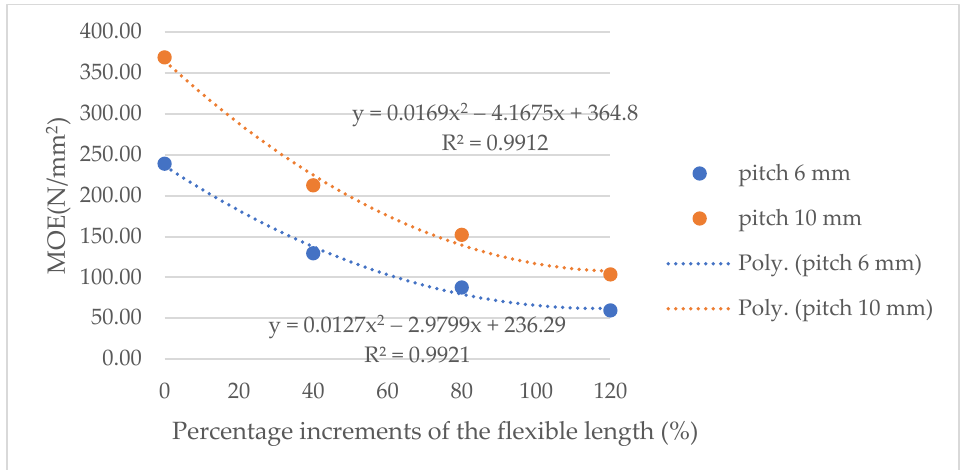
12 of 16 Figure 10. Mean values of the maximum deflection for combinations of model pitch and flexible length. According to [3], the kerfing technique promotes flexible surfaces, but it reduces the load carrying capacity of the panels so that higher density cuts (larger pitch) lead to more flexible but lower load bearing structures. This is confirmed by results in Table 3 and Fig- ure 9, when comparing the impact of the kerfing pitch for the same flexibilization length: higher frequency cuts caused a lowering in the MOR. Chen et al. [3] recommend, when designing desired geometrical shapes, to consider the kerfing pitch so that a balance be- tween panel flexibility and bending strength is reached. It was observed and tested with ANOVA, that combinations 6/70 and 10/110 had similar values of the MOR and maximum deflection, although the combination 10/110 has a 20% lower stiffness. This result is in- spiring when the same deflection of the sample is envisaged but on different flexibiliza- tion lengths, giving the possibility of achieving the goal by simply changing the frequency of the model. A greater number of tests and combinations of flexibilization parameters are needed in order to optimize the selection of the best combination for achieving the desired